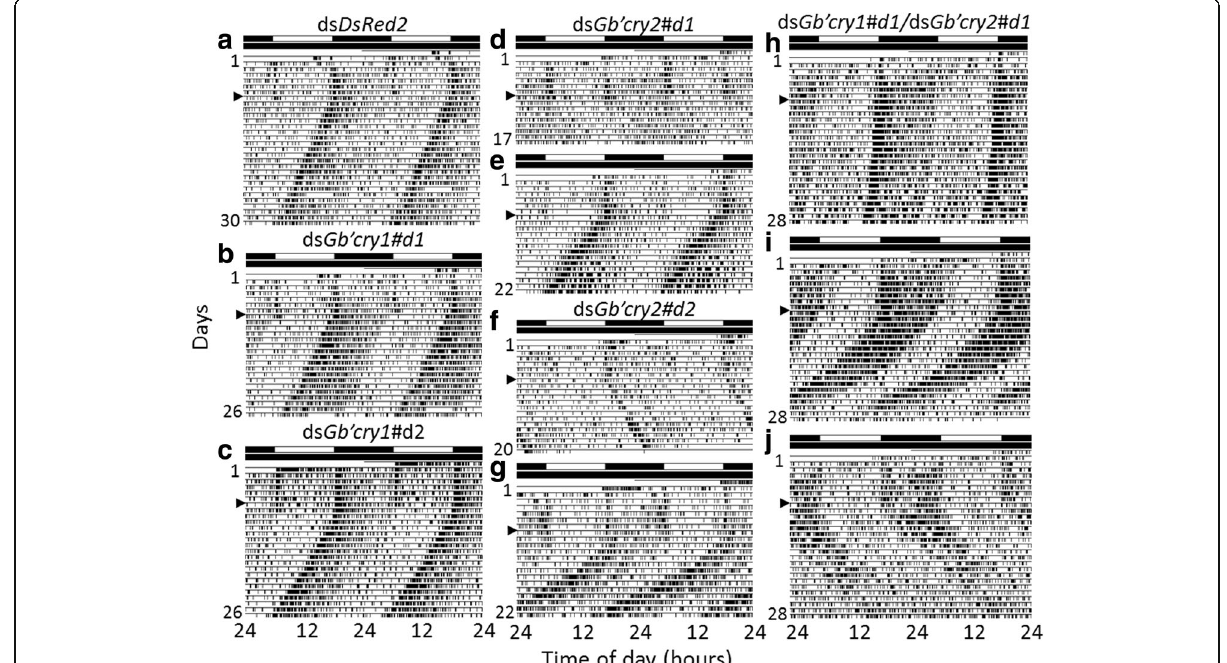
Fig. 3 Double-plotted actograms showing locomotor rhythms of crickets Gryllus bimaculatus . ( a – j ) Locomotor activity of DsRed2 RNAi ( a ), Gb ’ cry1 RNAi ( b , c ), Gb ’ cry2 RNAi ( d – g ), or Gb ’ cry1 RNAi and Gb ’ cry2 RNAi ( h – j ) crickets recorded under LD 12:12 and DD at a constant temperature of 25 °C. Arrowheads indicate the day when the crickets were transferred from LD to DD. Gb ’ cry1 RNAi crickets showed a locomotor rhythm free-running in DD with a period similar to that of DsRed2 RNAi crickets ( a – c ), but Gb ’ cry2 RNAi and Gb ’ cry1 / Gb ’ cry2 double RNAi crickets showed variable free-running periods ( d – j ). For further explanations, see the